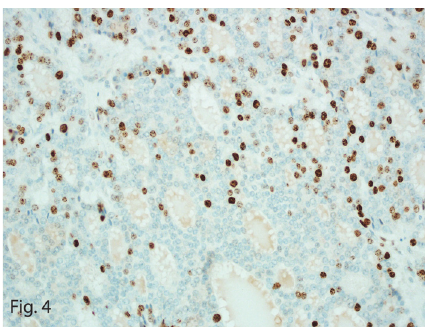
Figure 4: Ki-67 expression in tumor cells (20% mitotic labeling index, original magnification ×